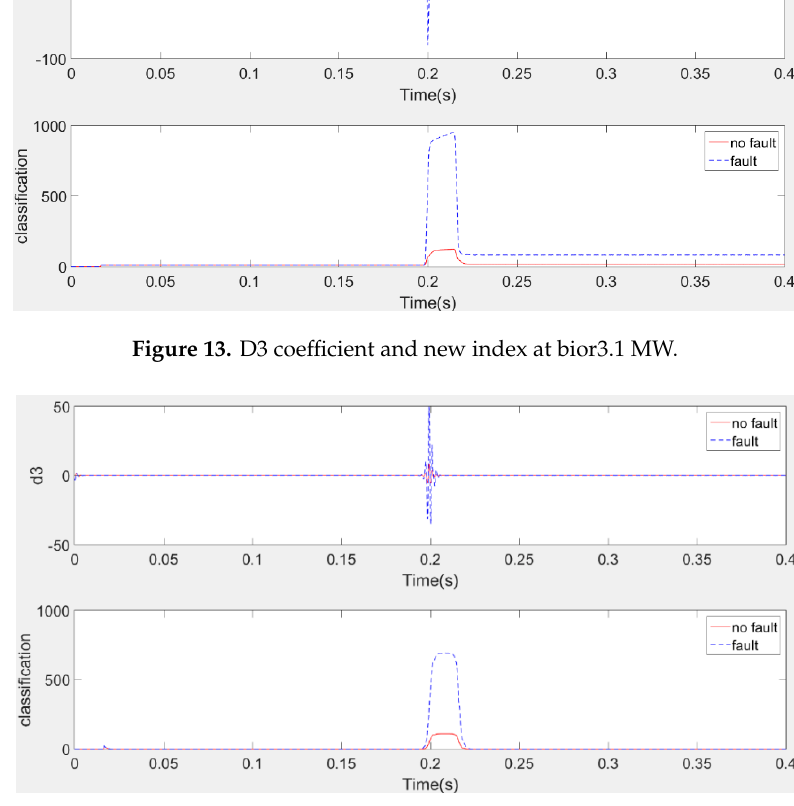
Figure 14. D3 coefficient and new index at coif4 MW.